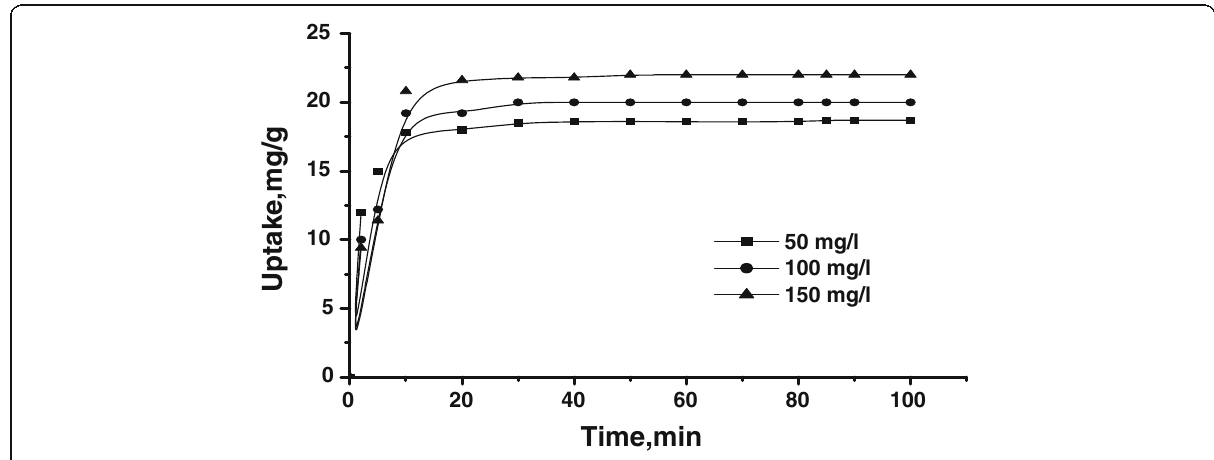
Fig. 8 Effect of contact time of AO67 onto resin polystyrene foam